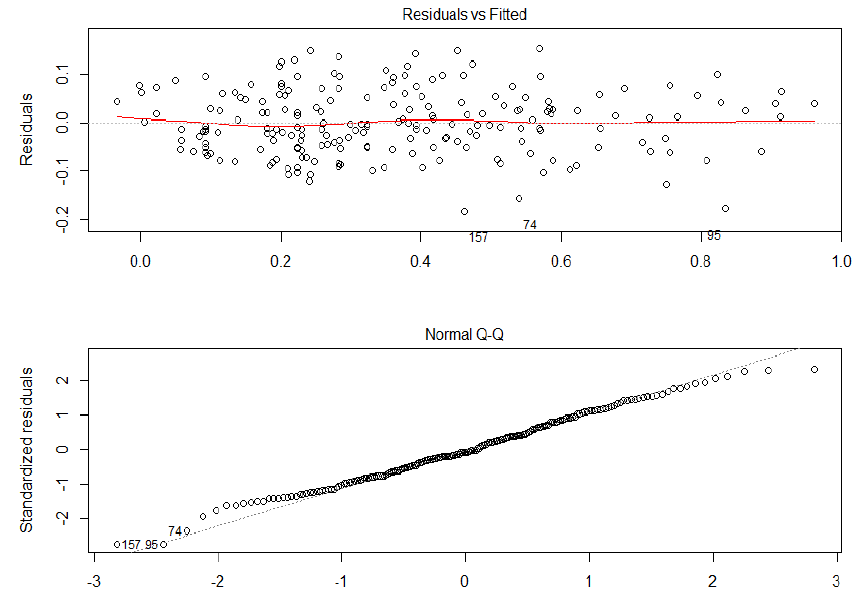
Figure 7. Residuals with constant variance. Linear fit of the predictor variables of ( 3